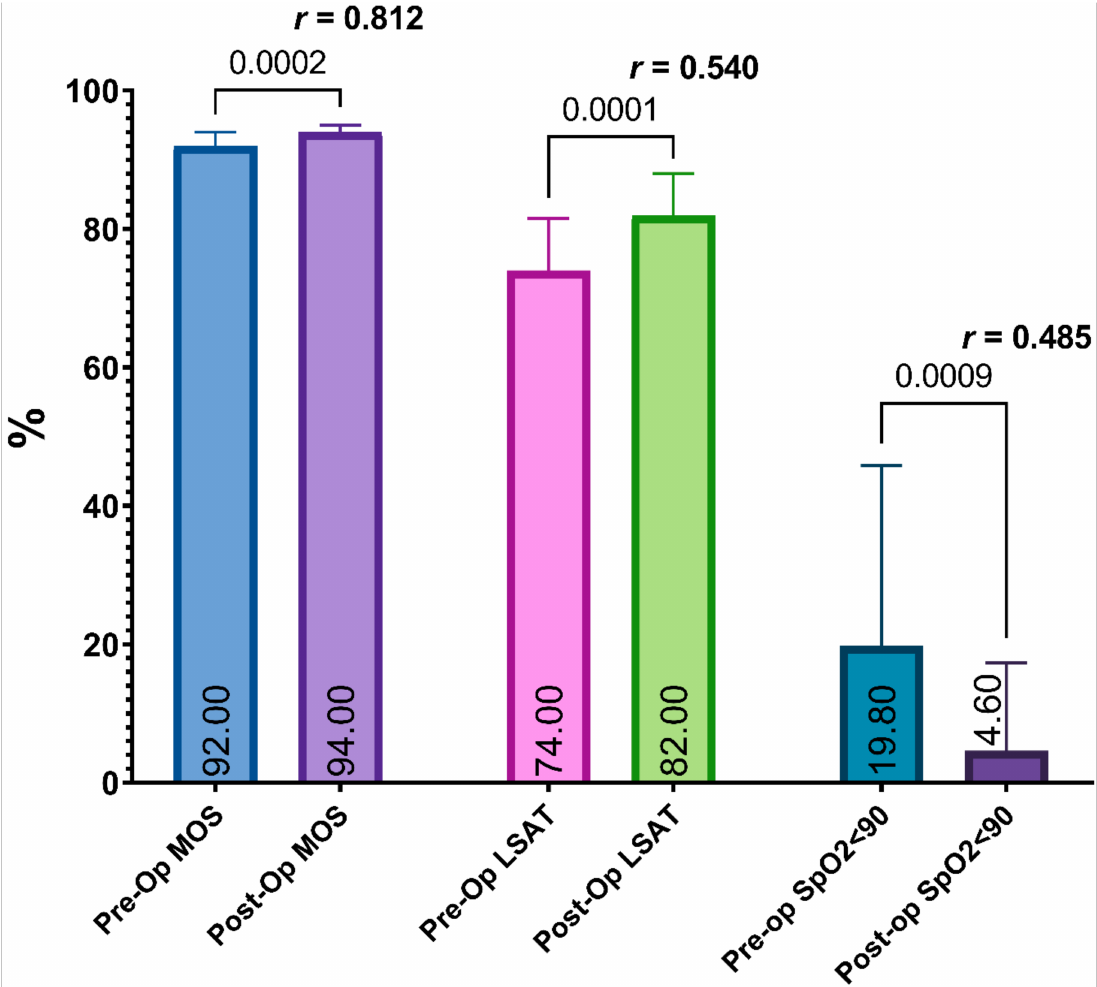
Figure 7. A pre- and post-operative comparison of the median and interquartile range values of the mean oxygen saturation, lowest oxygen saturation, and time of sleep spent with blood oxygen saturation less than 90%. The median values are shown inside the columns and the p -value is shown above the columns. The effect size ( r -value) is shown above the